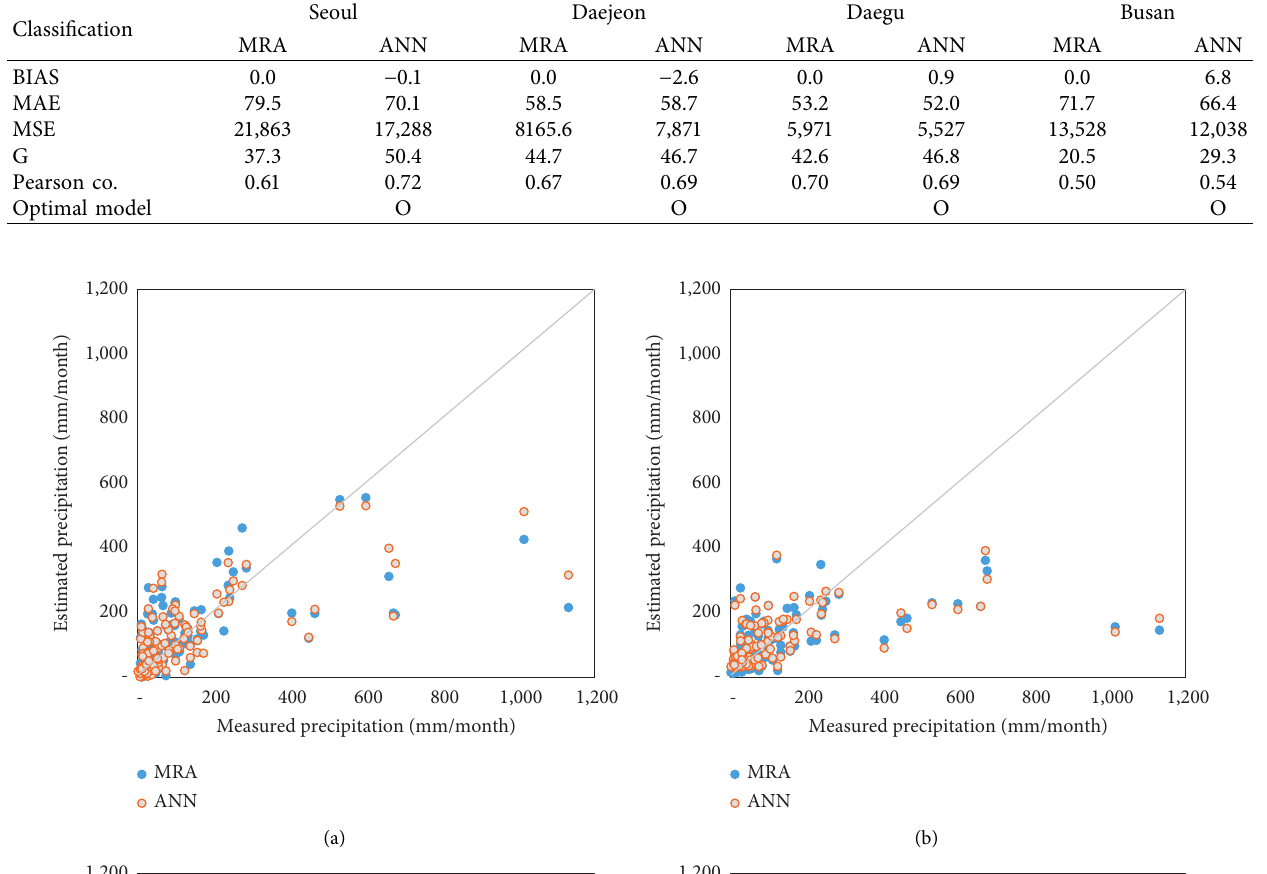
Table 6: Accuracy assessment results between ANN and MRA.